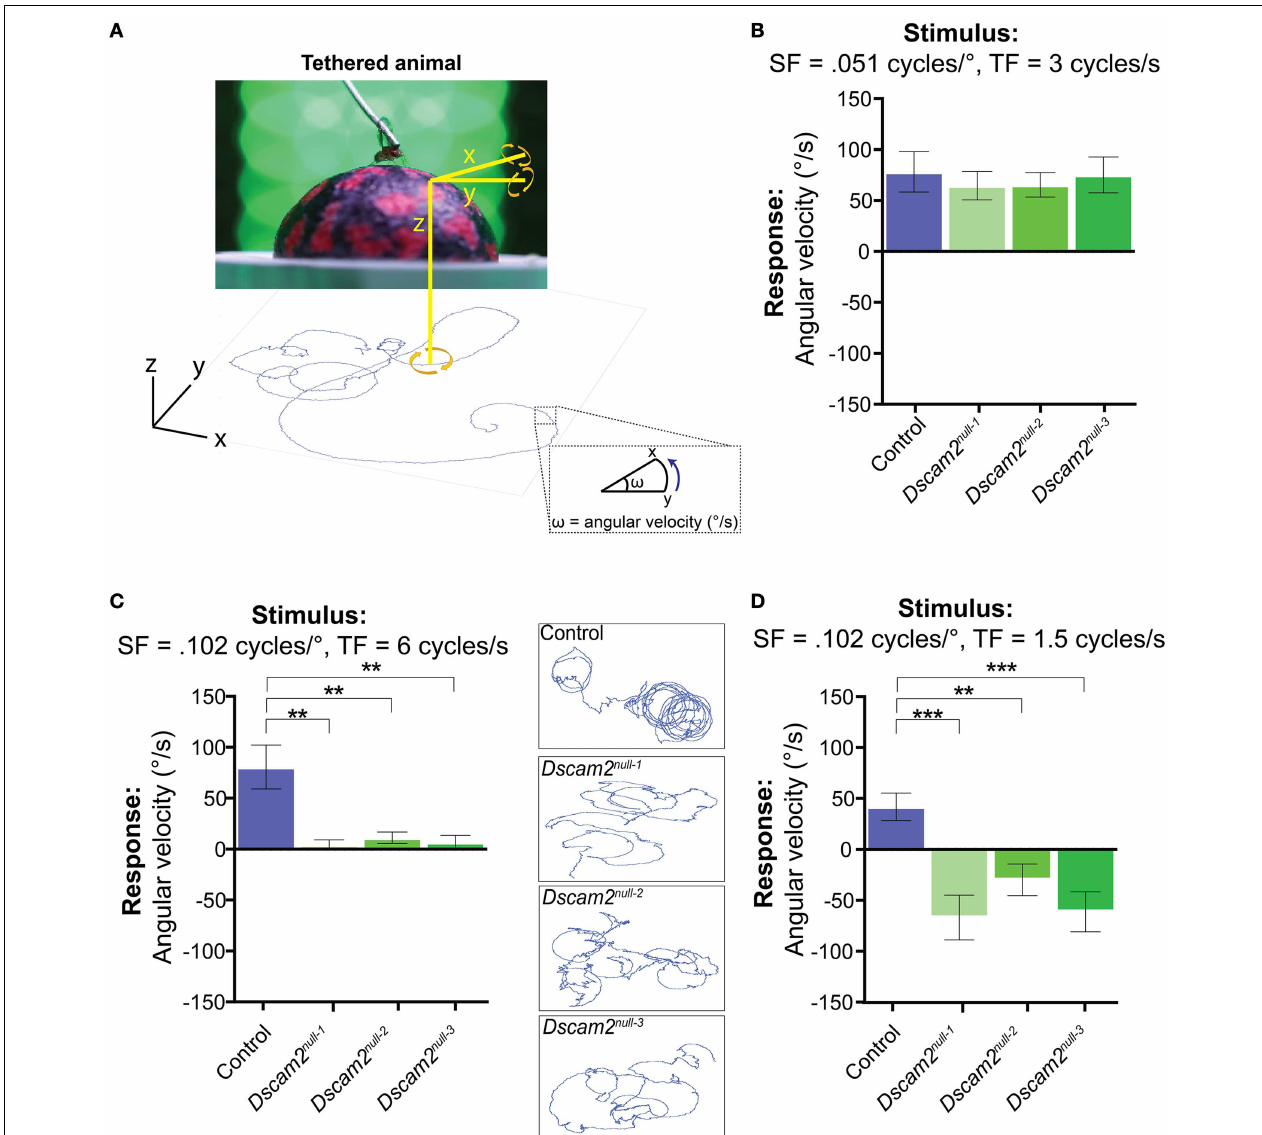
FIGURE 4 | Dscam2 mutant flies have conditional responses to motion in the tethered-walking assay. (A) A tethered-walking assay to assess motion tracking in flies. This assay uses a tethered fly on an air-supported ball surrounded by LED panels displaying apparent motion. The movement of the ball is tracked by a camera and the software program FicTrac which translates rotation of the ball into a 2D fictive path. From this path the angular velocity can be determined and used as a measure of the response to the visual stimulus. (B–D) Visual responses of control (blue), Dscam2 null − 1 (light green), Dscam2 null − 2 (green) and Dscam2 null − 3 (dark green) to specific grating parameters in which the mutants have conditional responses; (B) Visual response (in angular